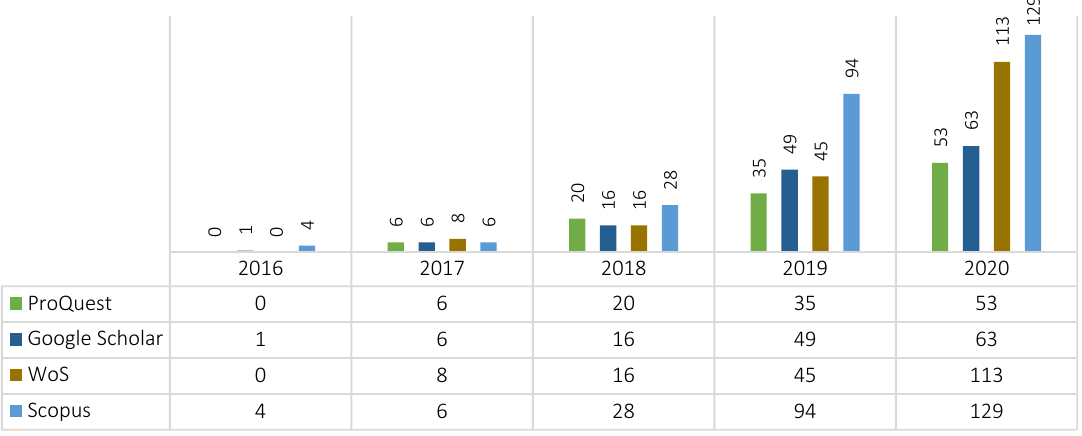
Figure 3. Publication analysis by year in the four databases.